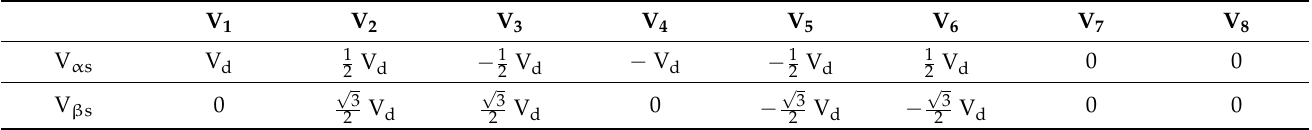
Table 3. Stationary (α-β) stator voltages. Table 4. Comparison of SCC and VC